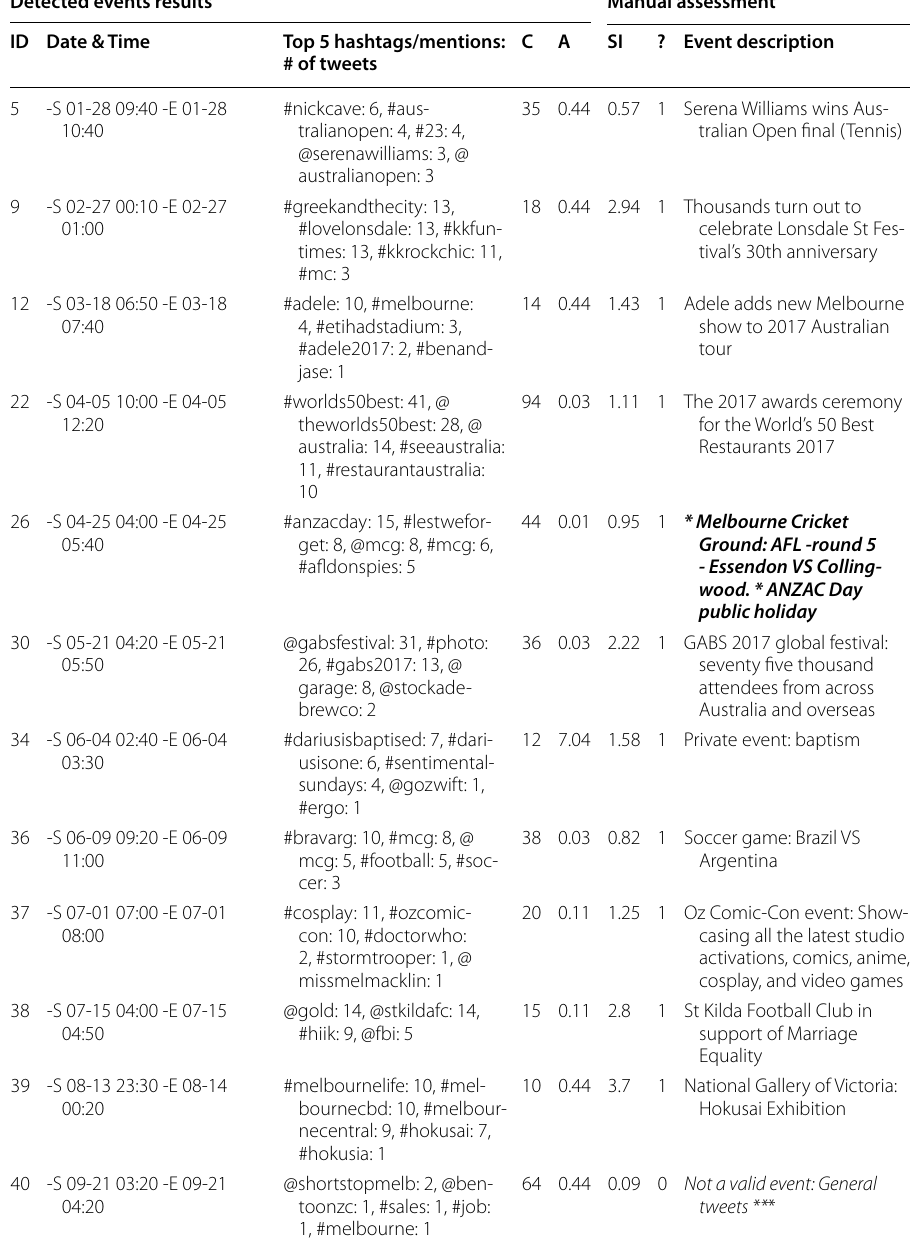
Table 7 Precision results: Melbourne detected events in 2017 using geotagged tweets (random selection of 45 events) Detected events